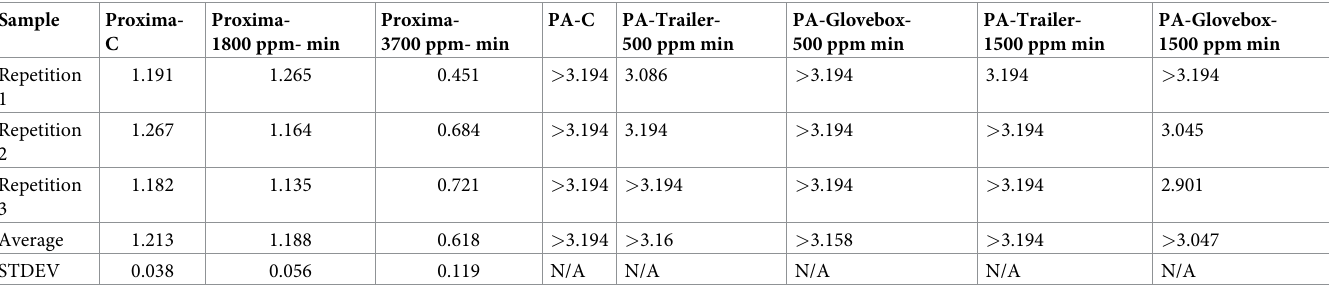
Table 6. Hydrostatic pressure results of Proxima and Prestige Ameritech gowns treated by PlasmaROS.